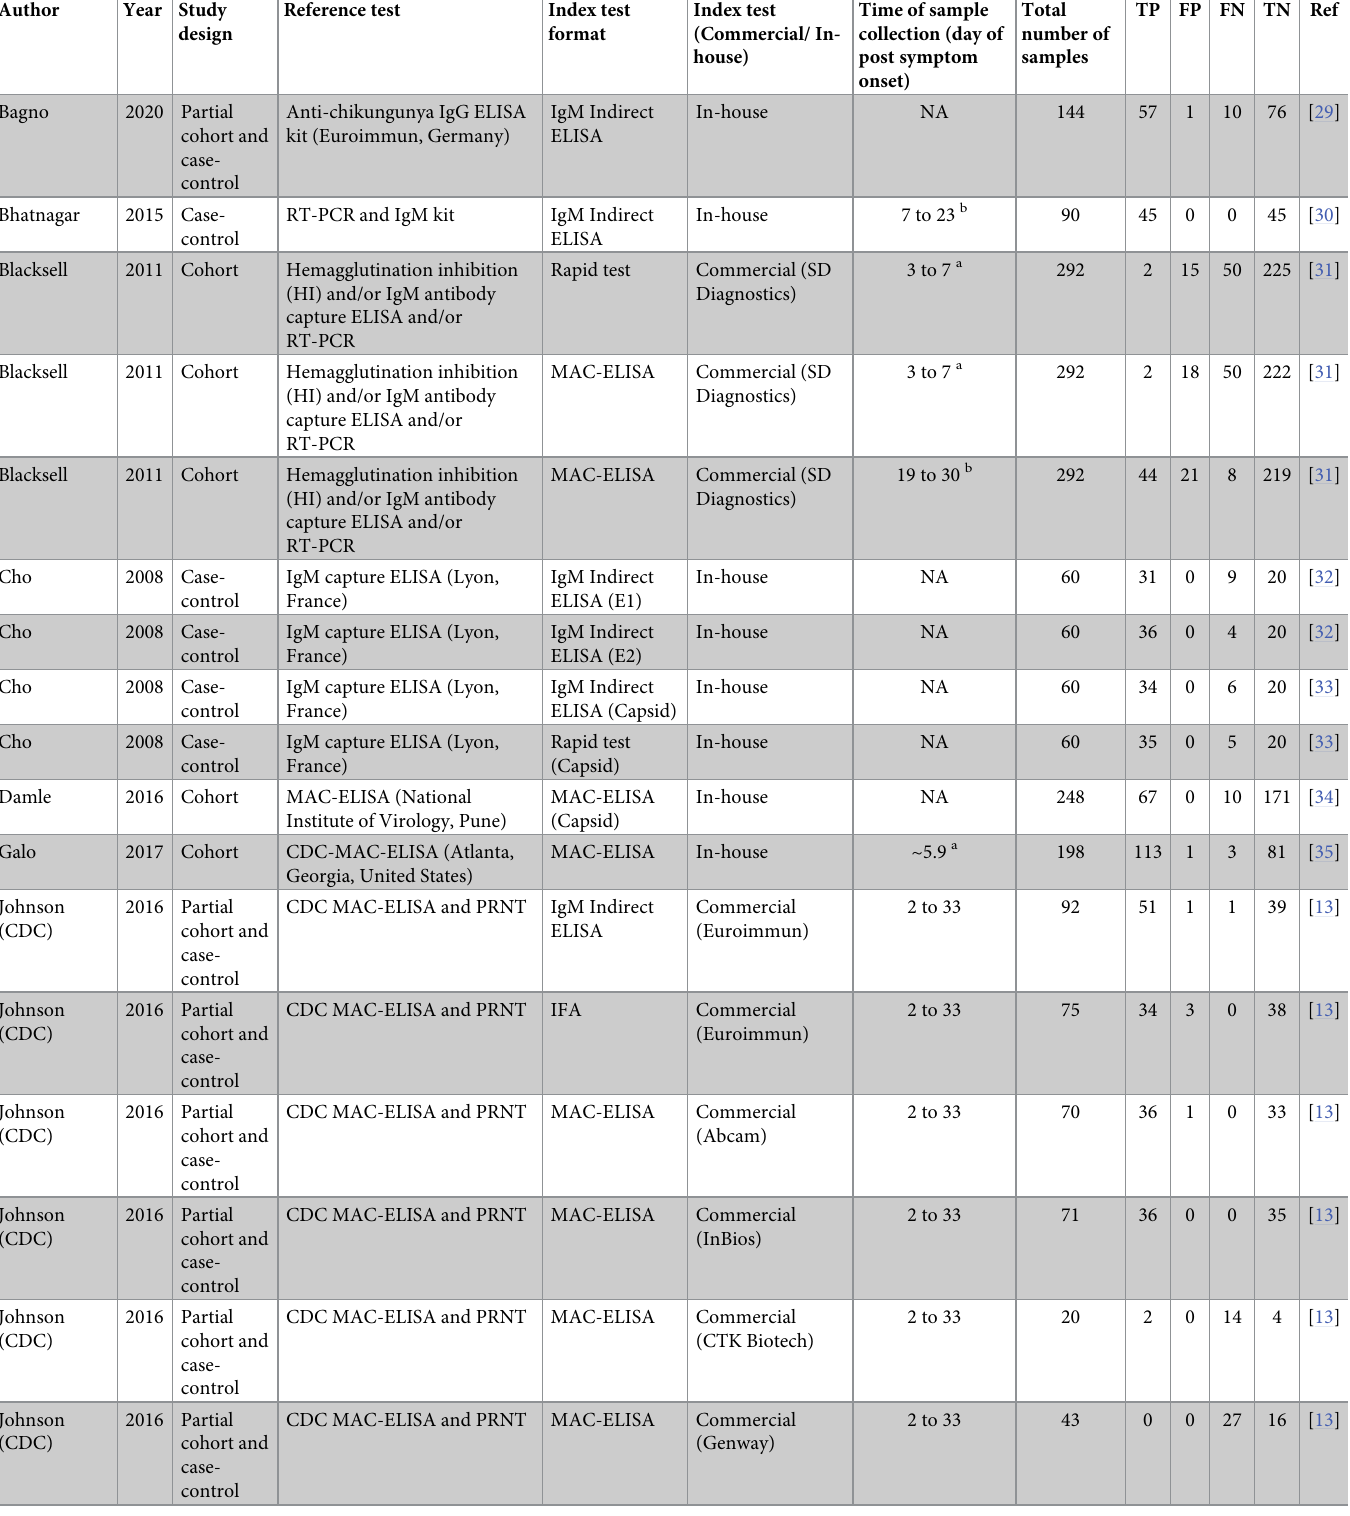
Table 2. Characteristics of studies on IgM detection tests included in the